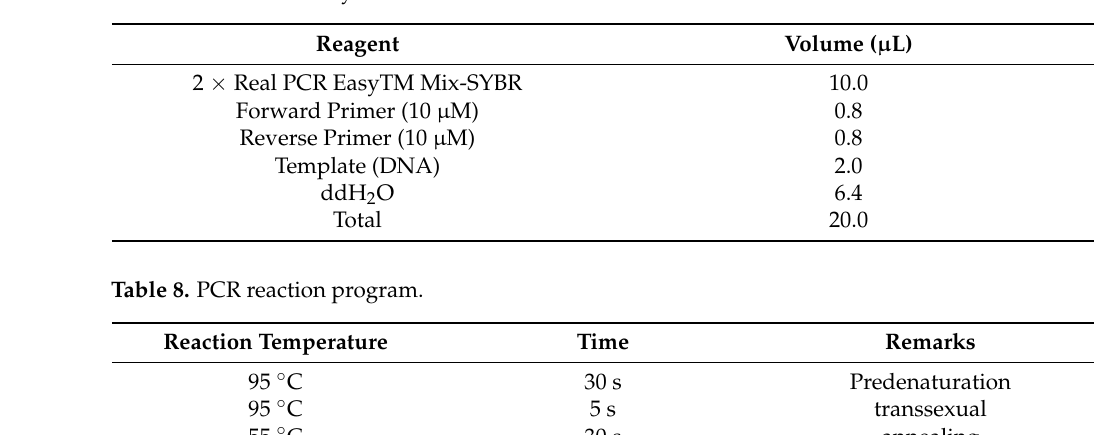
Table 7. PCR reaction system.